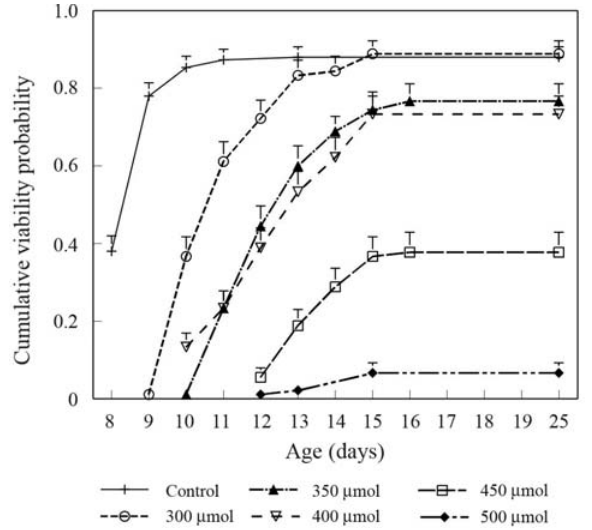
Figure 1 - Diphenyl diselenide molarity and Drosophila melanogaster vi- ability and developmental delay curves for the egg to pupa stage. For each offivereplicates,30eggswereplacedonbanana-agarcontainingdifferent